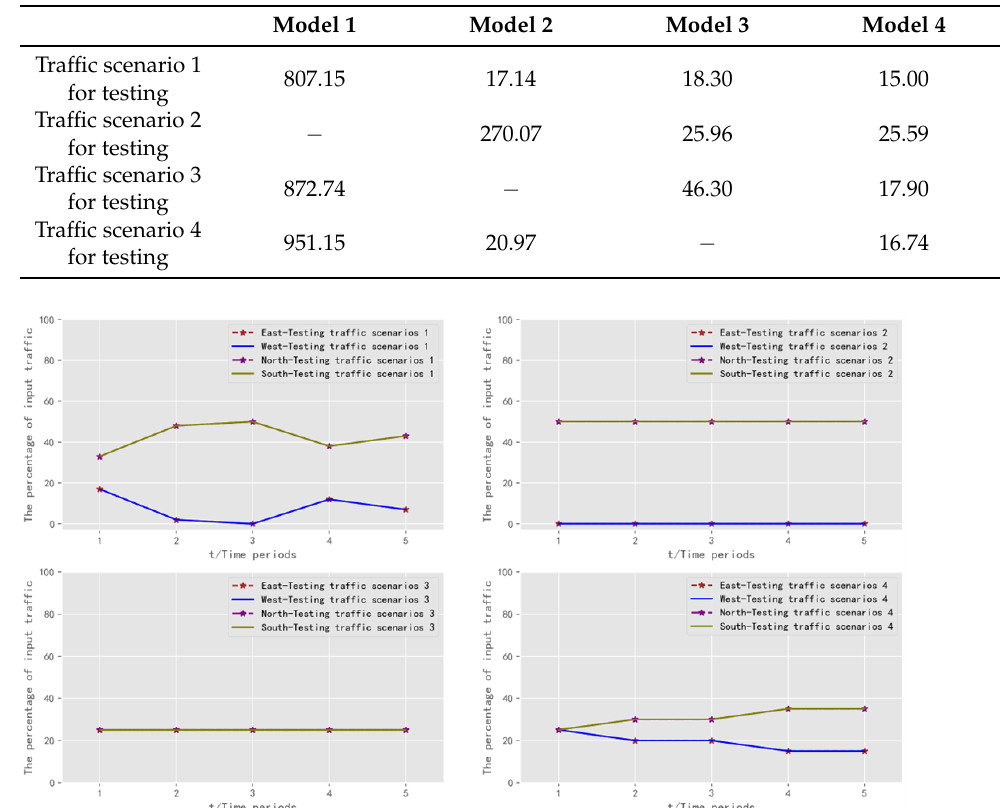
Table 12. Average cumulative delay of the four models for each test traffic scenario.